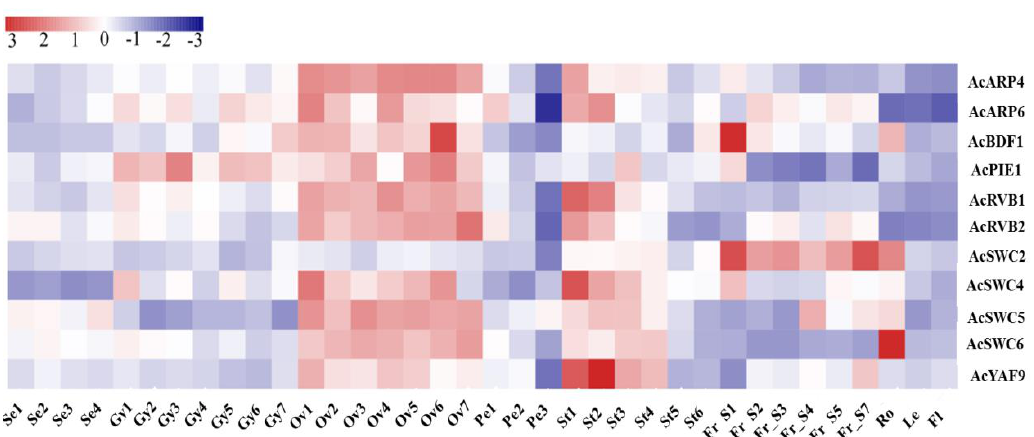
Figure 4. Expression profiles of pineapple SWR1-C subunits in different organs and developmental stages. Red color indicates high levels of transcript abundance, and blue color indicates low transcript abundance. The color scale is shown at top left side of the figure. Sample details are mentioned at the bottom of each lane: sepal Se1–Se4, gynoecium Gy1–Gy7, ovule Ov1–Ov7, petal Pe1–Pe3, stamen St1–St6, fruit Fr_S1–Fr_S7, root Ro, leaf Le and flower Fl. “S” is the abbreviation for “stage.” pineapple SWR1-C subunit names are shown on the right side of the figure.